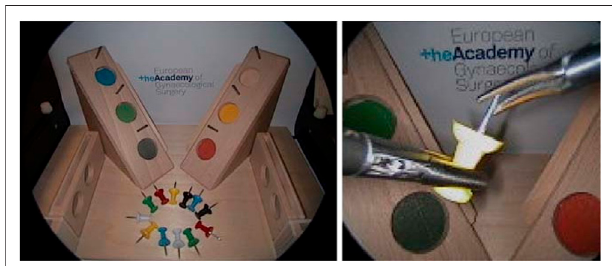
FIGURE 11 | LASTT (European Academy of Gynaecological Surgery, 2020)laparoscopictrainingmodel.Initalpositionofthepinsbeforestartingthe bi-manual coordination task (left). Procedure to pass a pin from the non- dominant to the dominant hand